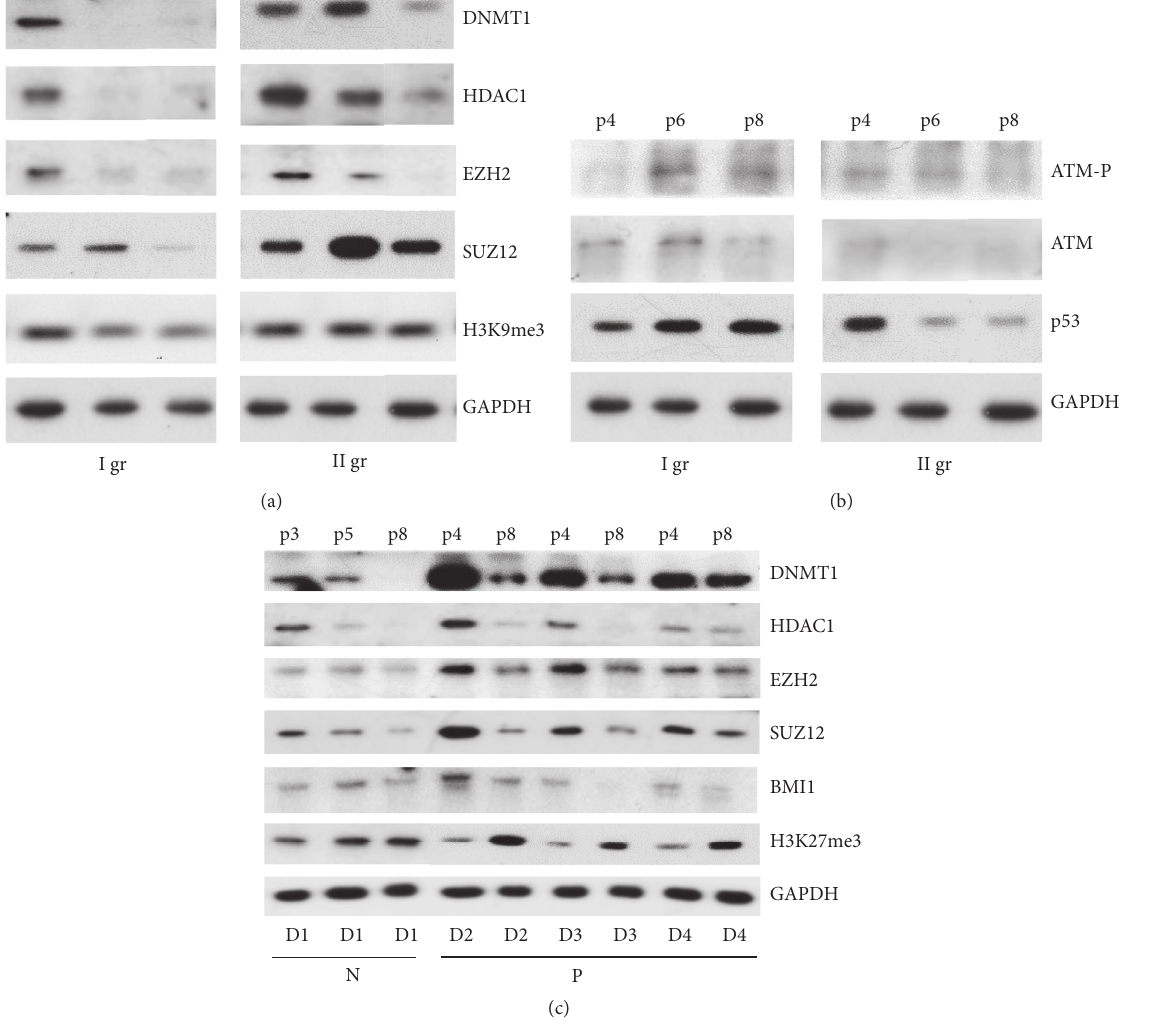
Figure 5: Epigenetic changes during passaging of MSCs cultures derived from AF of normal and pathological gestation. Lysates from cell samples of healthy (N) donors (D) and with fetal abnormalities (P) were subjected to Western blot analysis to monitor the expression of proteins using the indicated antibodies. (a, b) Representative blots of proteins from cell cultures of two groups (I and II) during culturing at passages 4, 6, and 8 and (c) from cell cultures derived from AF of normal gestation (D1) and individual donors (D2–D4) carrying fetus abnormalities. The data is representative of at least two gels showing similar